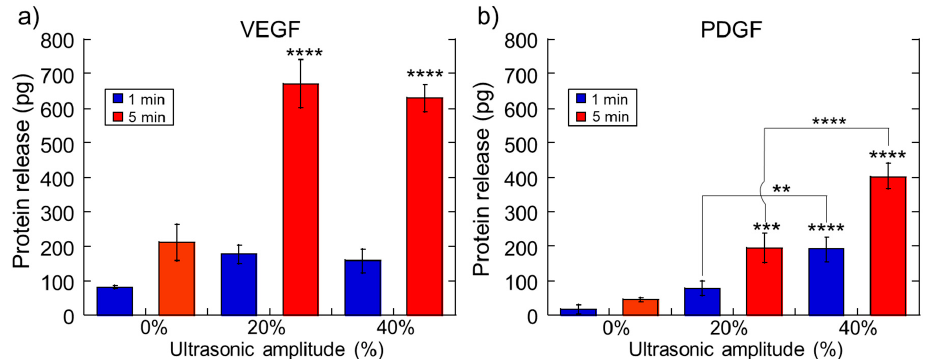
Figure 3. The amplitude and duration of ultrasonic stimulation impact the amount of signaling factor released. Release vs. ultrasonic intensity for Vascular Endothelial Growth Factor (VEGF) ( a ) and Platelet-Derived Growth Factor (PDGF) ( b ). *, **, ***, and **** indicate statistically significant differences with p < 0.05, 0.01, 0.001, and 0.0001, respectively, compared to controls (0% amplitude) unless otherwise specified with lines. N = 4.